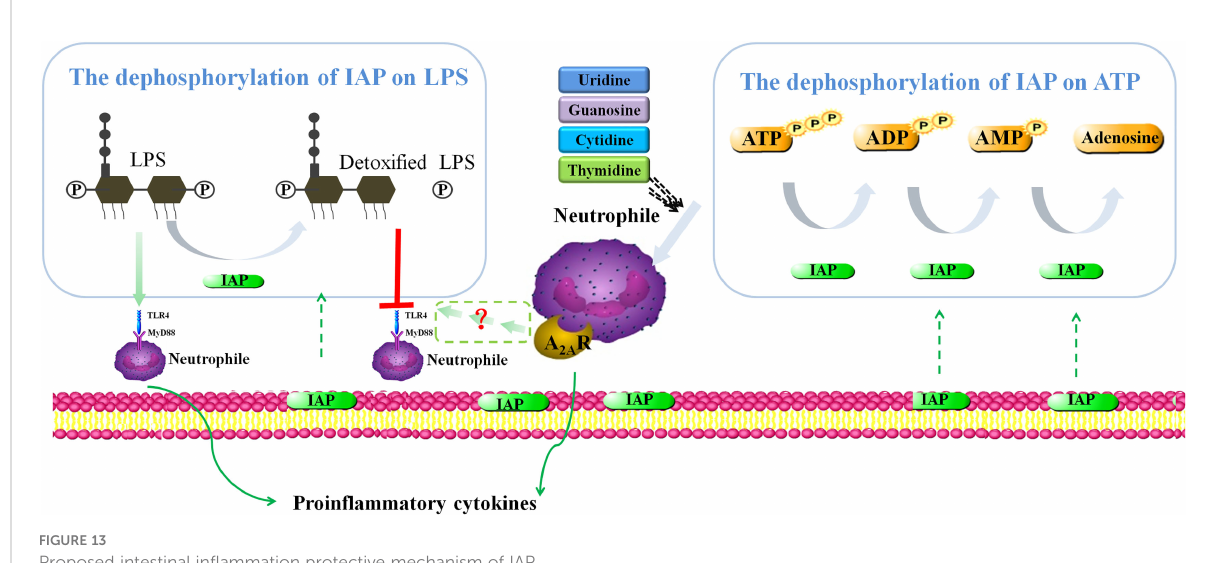
FIGURE 13 Proposed intestinal in fl ammation protective mechanism of